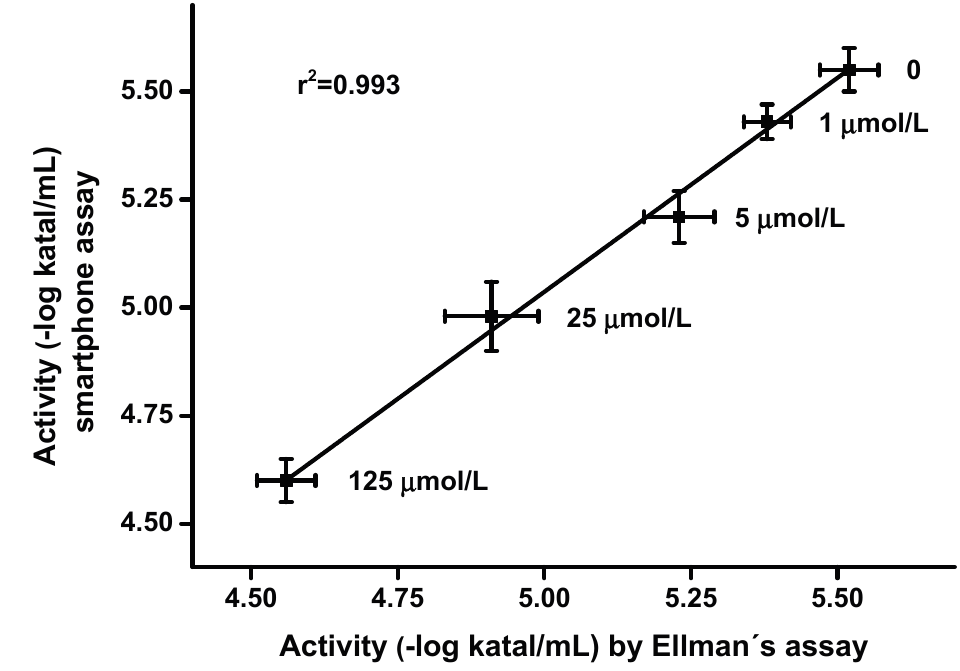
Figure 5. Validation of the smartphone-based assay using plasma samples spiked with carbofuran. Standard Ellman’s assay was used as a reference. The concentration of carbofuran in the plasma sample is written beside the experimental point. Error bars indicate standard deviations for n =